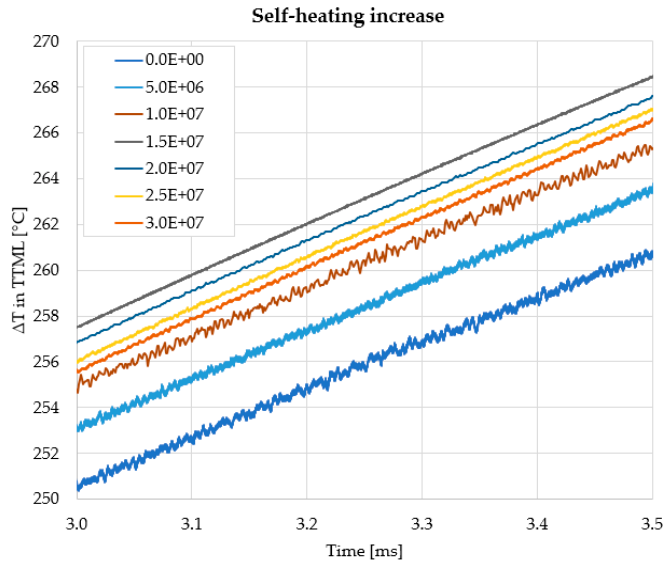
Figure 16. The temperature increase with respect to ambient for chips tested in the 100%AA configuration—each trace is a capture taken after 5 million cycles, as the legend suggests.